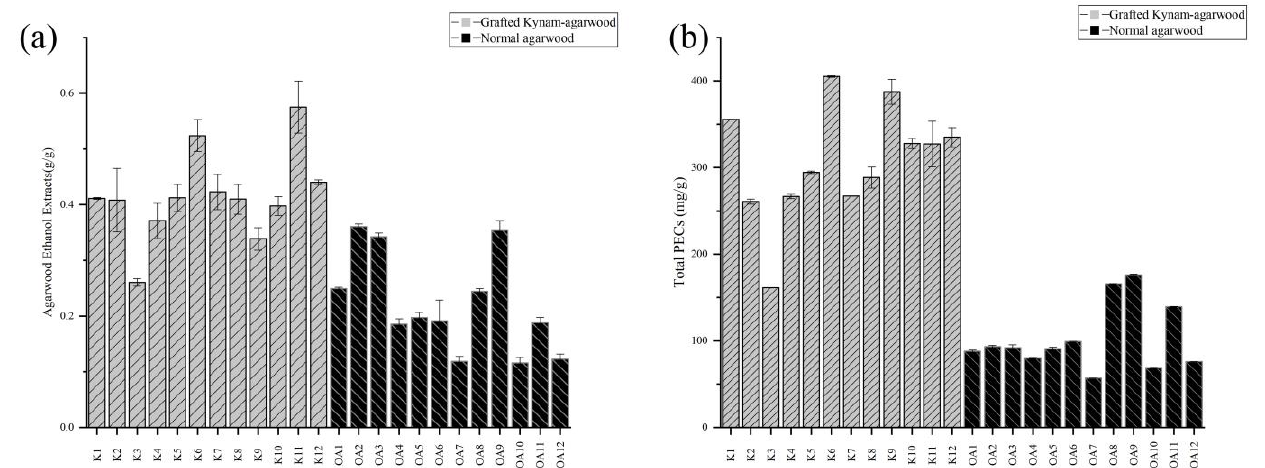
Figure 2. Content of agarwood ethanol extracts ( a ) and total PECs ( b ). The ethanol-soluble extract content was determined according to the procedures of the Chinese Pharmacopoeia. The total PEC content was measured at 254 nm with agarotetrol as the